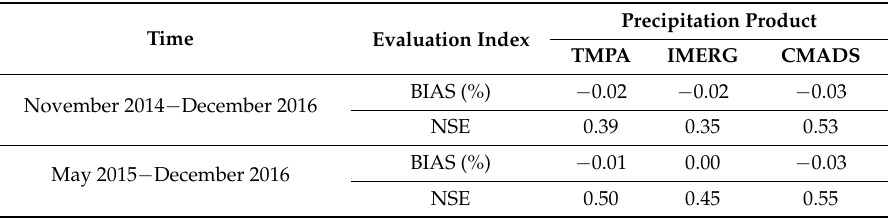
Table 4. Comparison of hydrological model simulation